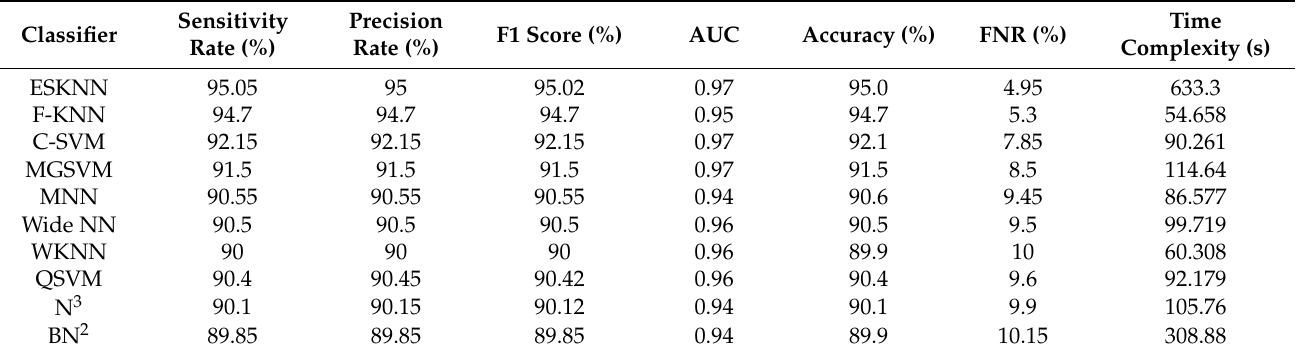
Table 3. Classification results after employing the proposed contrast enhancement step for deep features extraction.